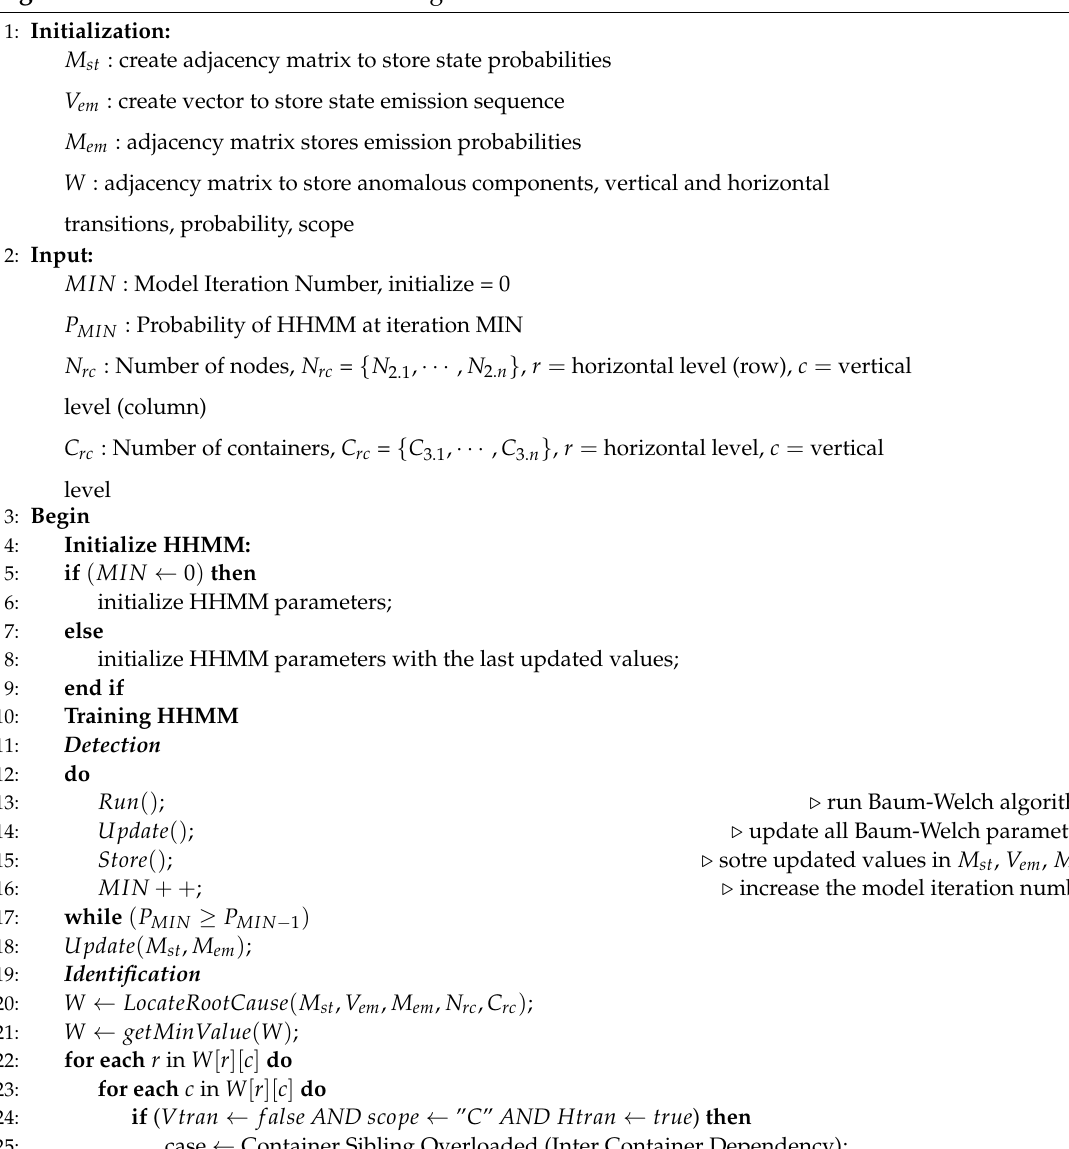
Algorithm 2 Detection-Identification